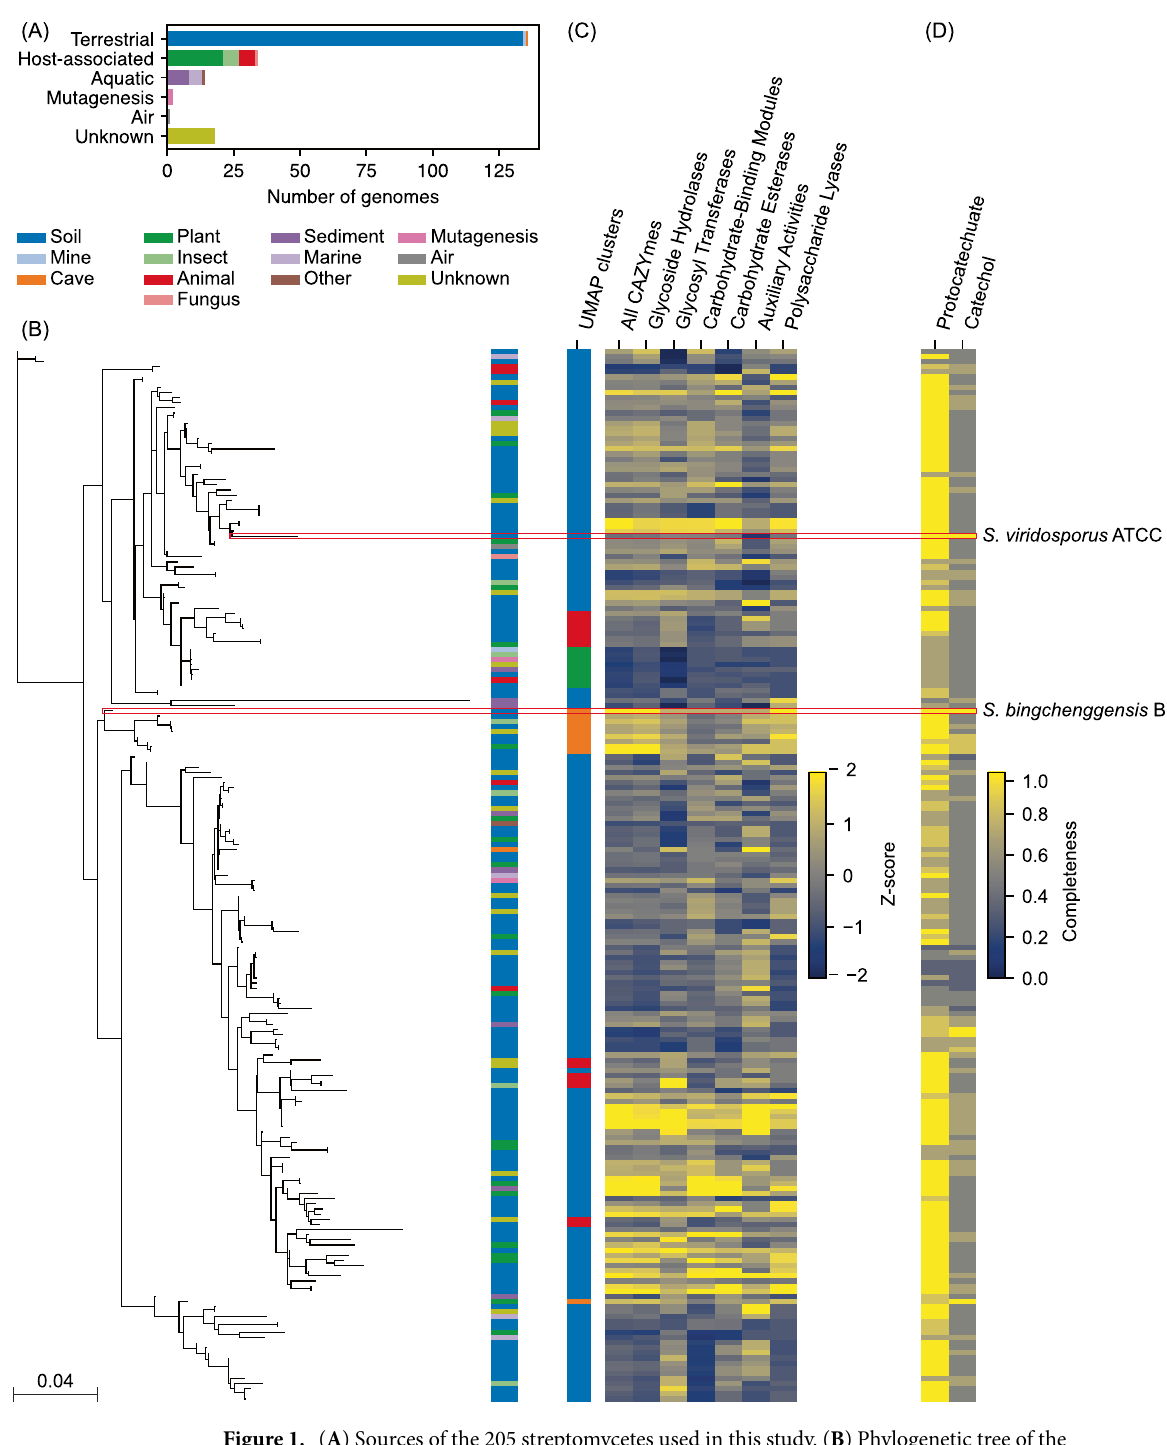
Figure 1. ( A ) Sources of the 205 streptomycetes used in this study. ( B ) Phylogenetic tree of the 205 streptomycetes using the 16S rRNA sequences. Sequences were aligned using PhyML. Red boxes indicate S. bingchenggensis BCW-1 and S. viridosporus ATCC 39115. ( C ) Clusters of the 205 strains based on the similarity of the 25 CAZymes families (see Fig. S3 for further information) and the relative numbers of CAZymes and CAZyme groups encoded in each genome. ( D ) Completeness of the protocatechuate and catechol catabolic pathways encoded in each genome. The pathway is complete if the genome encoded all the 6 enzymes each pathway requires. S. bingchenggensis BCW-1 and S. viridosporus ATCC 39115 encode the complete β-ketoadipate pathway responsible for protocatechuate and catechol catabolism. S. bingchenggensis BCW-1 also encodes a variety of CAZymes likely to be involved in polysaccharide